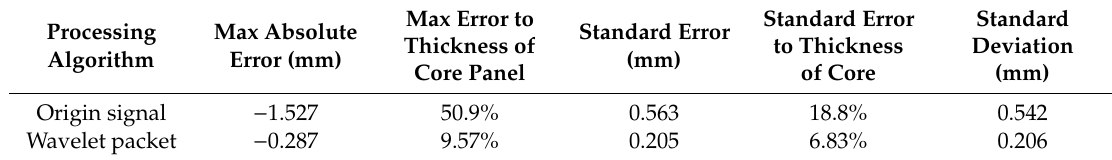
Table 5. Comparison of detection errors at 50 Hz sampling